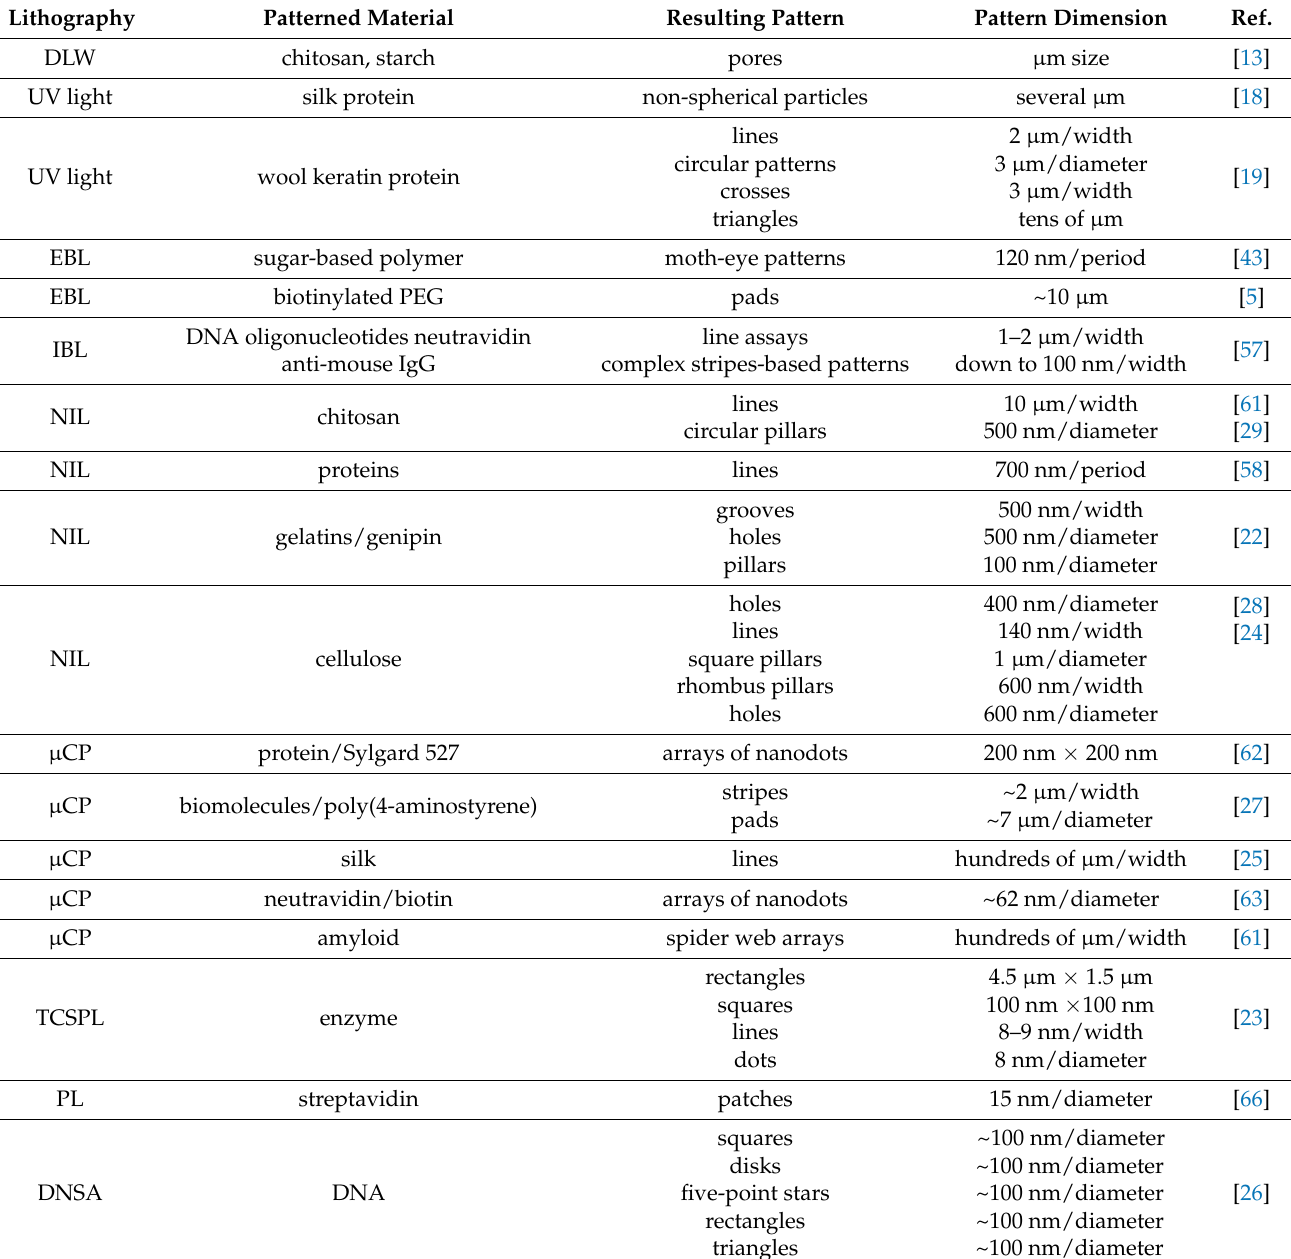
Table 1. Summary of various biopolymeric surface relief patterns that can be created using top-down and bottom-up lithographic